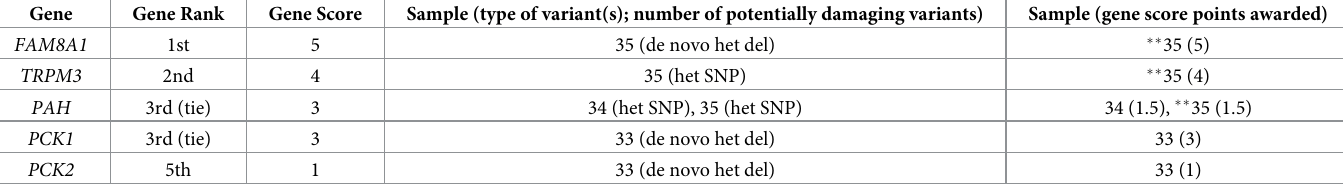
We ranked genes based on the average gene-disease connection and disease likelihood scores (S3 Table). The gene scores were equally divided among the samples when more than one sample shared a variant in that